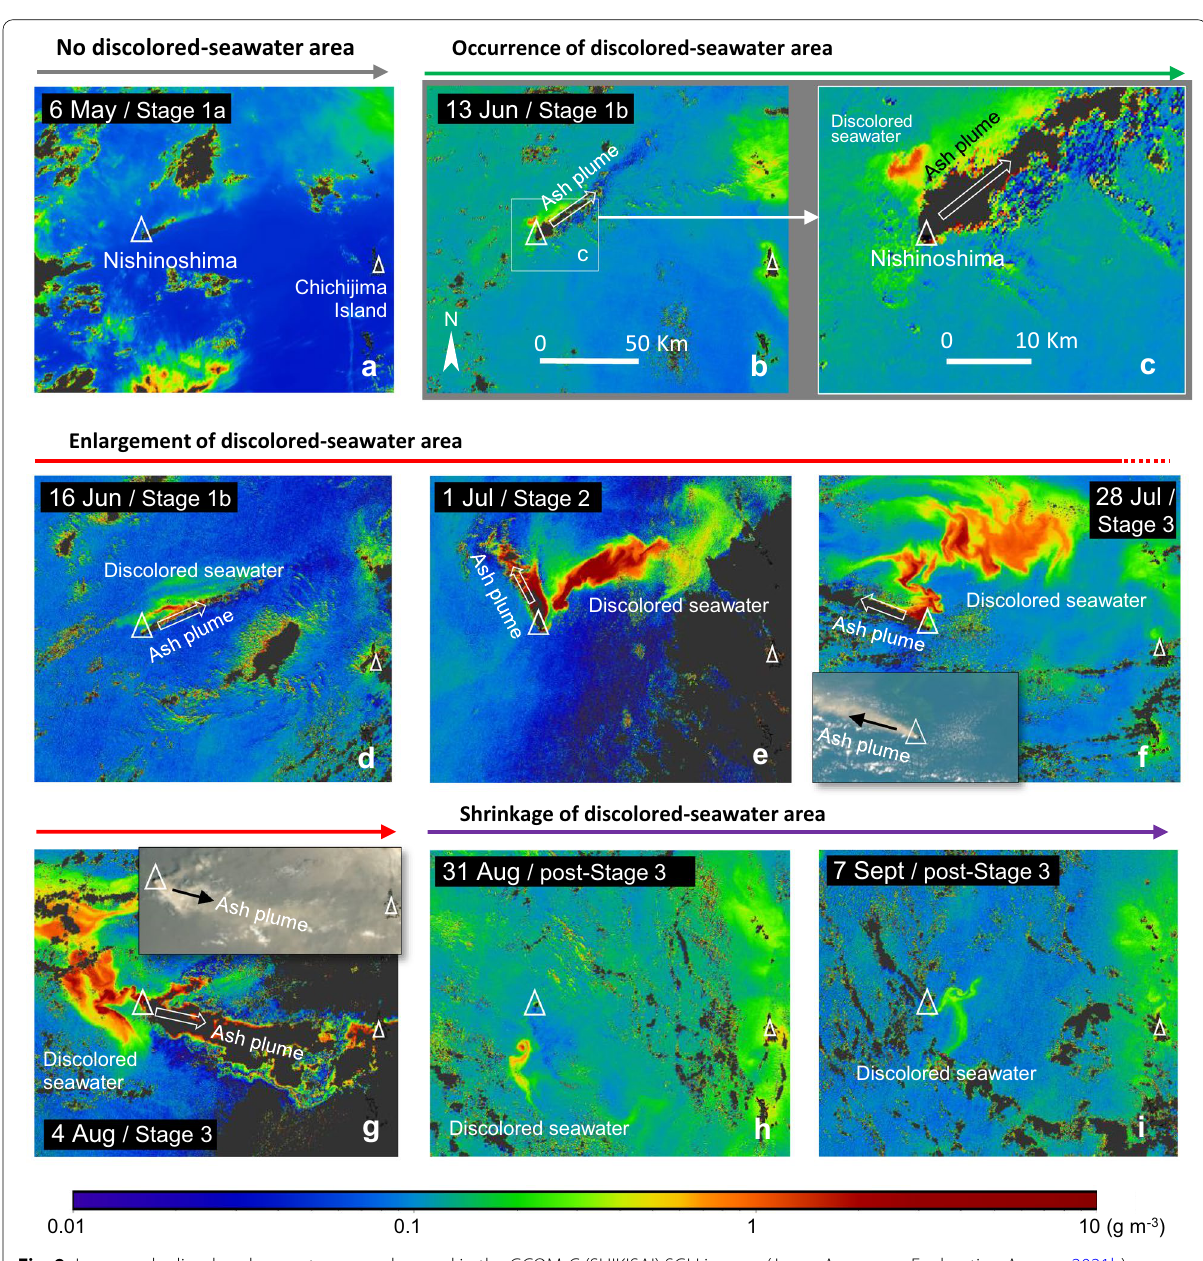
Fig. 9 Large-scale discolored-seawater areas observed in the GCOM-C (SHIKISAI) SGLI images (Japan Aerospace Exploration Agency 2021b). a 6 May (Stage 1a), b 13 June (Stage 1b), c close-up of the neighboring area of Nishinoshima in b, d 16 June (Stage 1b), e 1 July (Stage 2), f 28 July (Stage 3), g 4 August (Stage 3), h 31 August (post-Stage 3), i 7 September (post-Stage